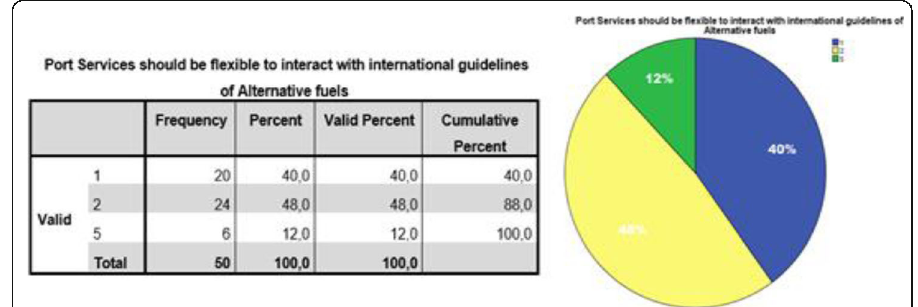
Fig. 7 Port Services should be flexible to interact with international guidelines of Alternative fuels. Source: by